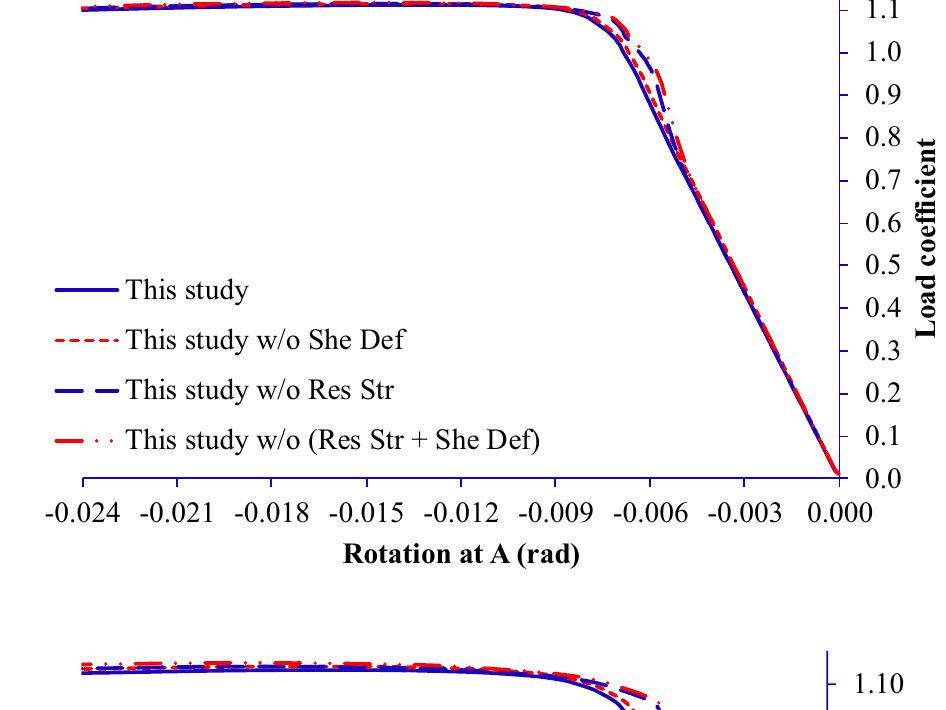
Fig. 17 Load-rotation relation- ship at A of six-story